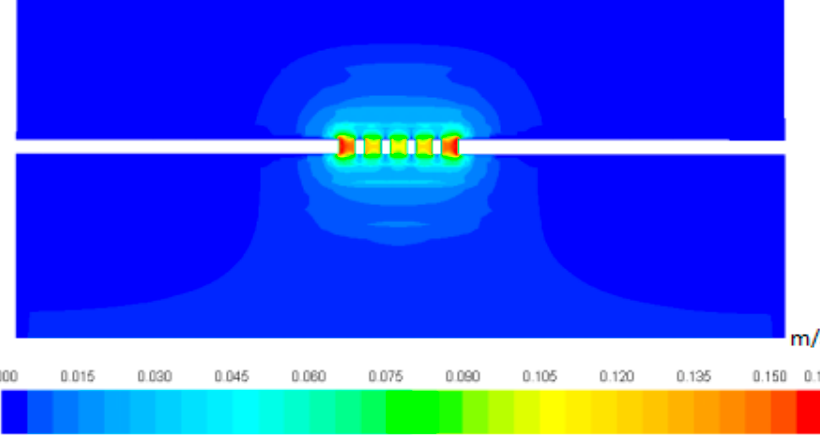
Figure 12. Acoustic velocity magnitude contour near perforated plate No. 2 absorber.